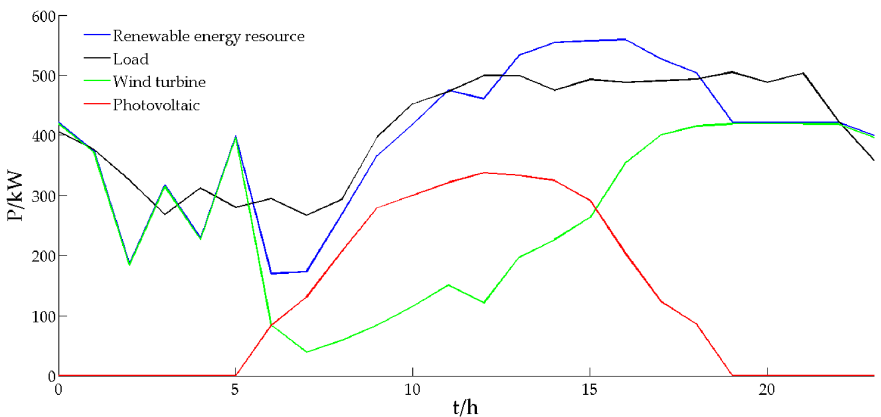
Figure 8. Typical daily load curves. Table 7. Environmental data.